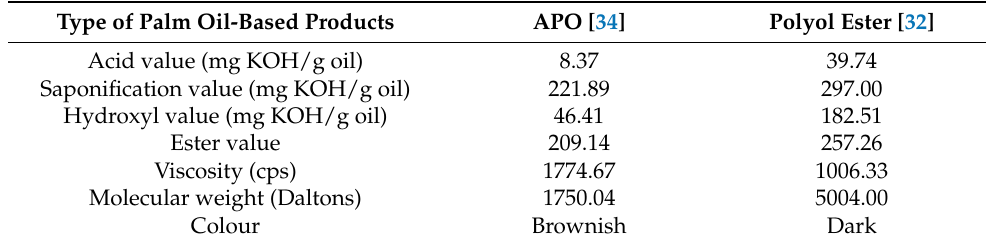
Figure 8. The general chemical structure and products of ( a ) polyol ester and ( b ) APO. Table 1. The physicochemical properties of APO and polyol